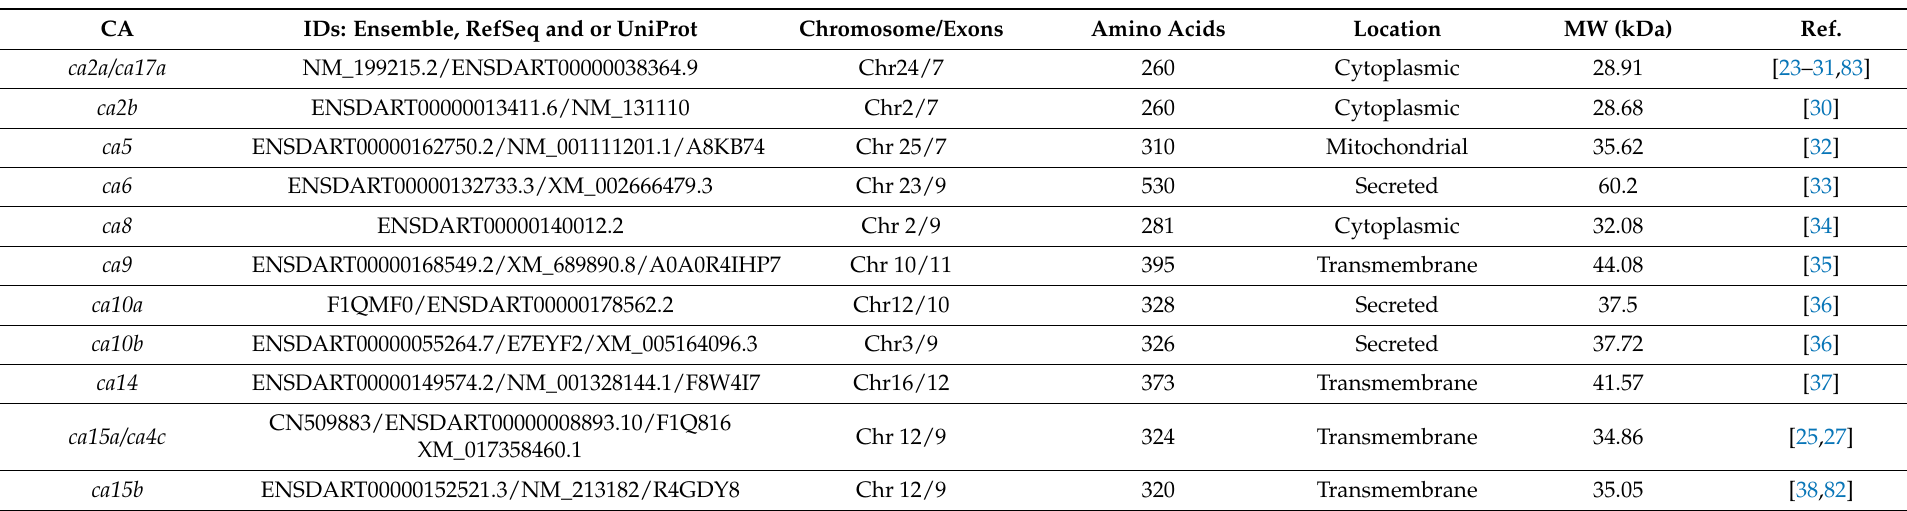
Table 2. The details of zebrafish carbonic anhydrases presented in the